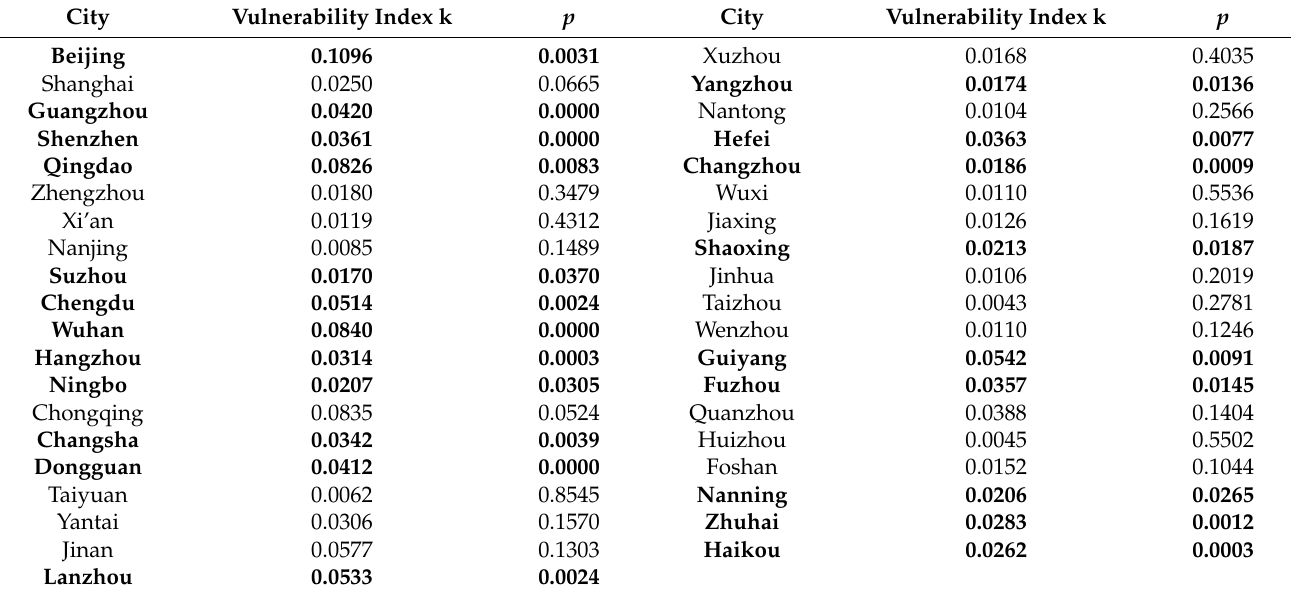
Table 1. k value of the traffic vulnerability index and p value of each